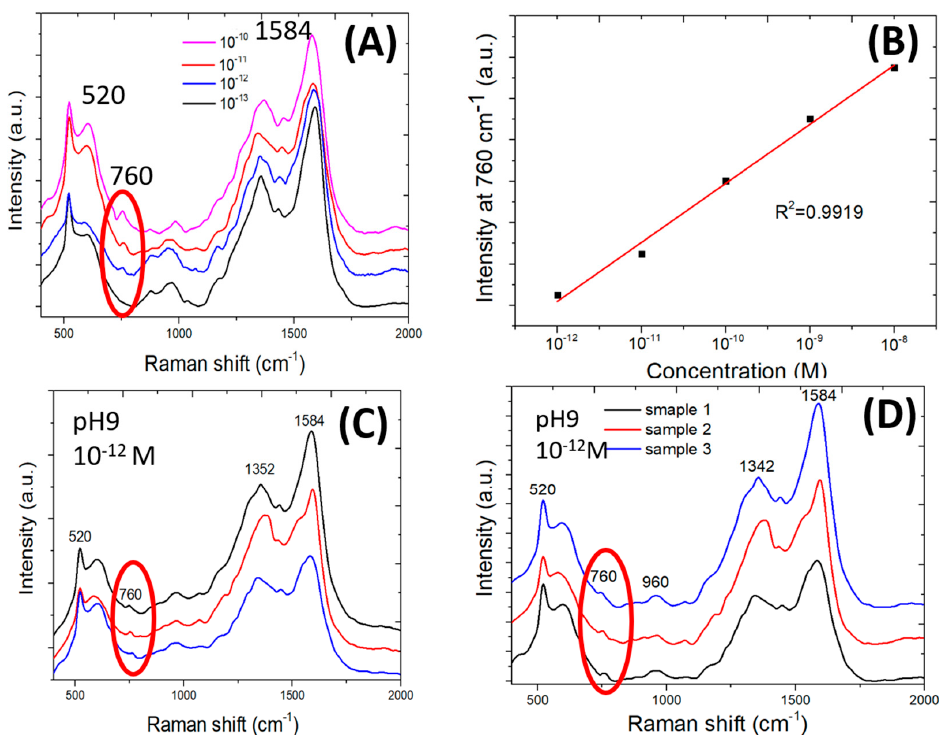
Figure 5. Raman spectra and intensity of Raman scattering signal. ( A ) Raman spectra of adenine of varied concentration in pH 9 water solution. ( B ) Raman scattering signal strength of adenine as a function of the adenine concentration. ( C ) Three Raman spectra measured at three di ff erent areas on a SERS sensor for 10 − 12 M adenine in pH 9 water solution. ( D ) Three Raman spectra measured using three di ff erent SERS sensors for 10 − 12 M adenine in pH 9 water solution.